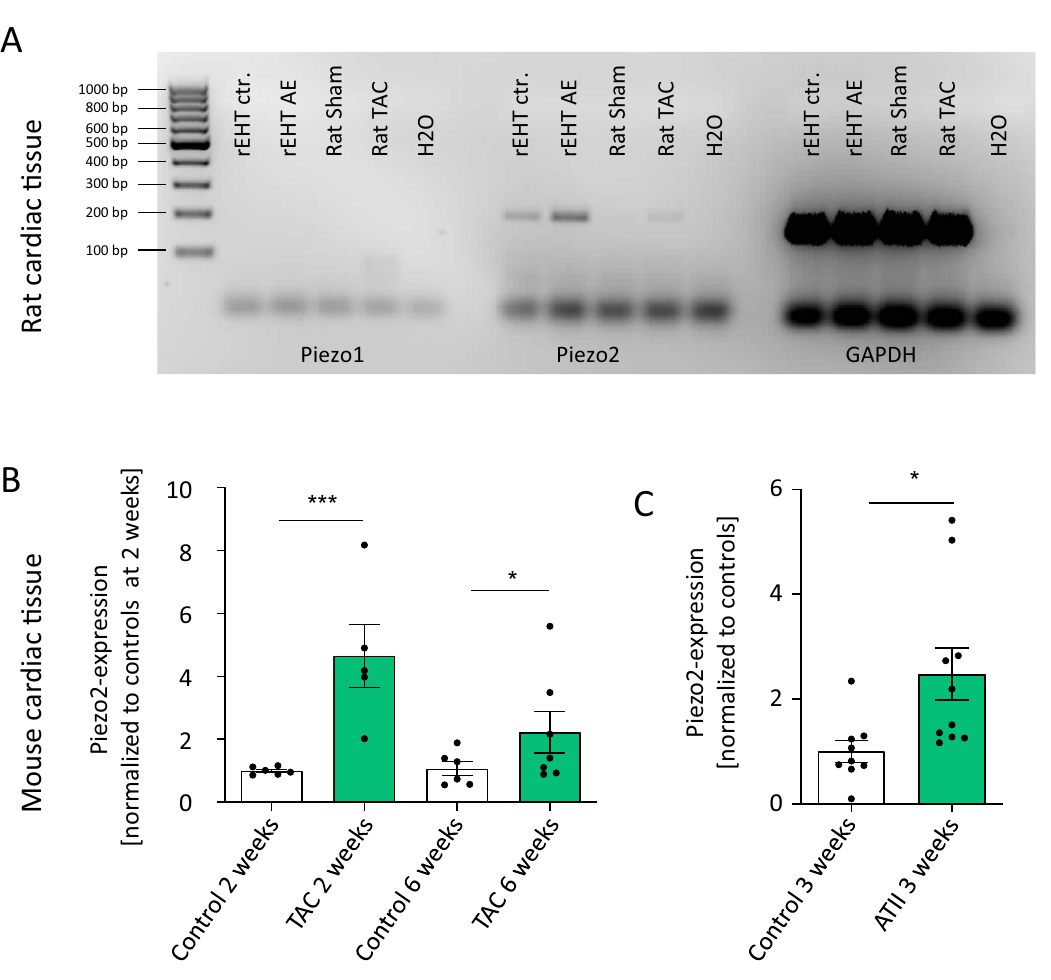
Figure 1. Upregulation of piezo2 in different cardiac stress models. ( A ) Semiquantitative PCRs for piezo1, piezo2 and GAPDH of control and afterload-enhanced (AE) rat EHTs as well as rat left ventricles after sham operation or TAC (transverse aortic constriction) surgery. Each lane represents the PCR-product from one sample (rat or EHT). The expected or detected PCR product sizes were 167 bp (piezo1), 200 bp (piezo2) and 155 bp (GAPDH). ( B ) Quantitative PCR for piezo2 expression in the left ventricles of control mice or after 2 or 6 weeks of TAC (n = 5–7). ( C ) Quantitative PCR for piezo2 expression in the left ventricles of control mice or after 3 weeks of continuous angiotensin II (ATII) application (n = 9–10). In ( B , C ) each dot represents the cardiac piezo2-expression of one mouse, averaged from two technical replicates. For better visualization the mean of control 2 weeks ( B ) or control 3 weeks ( C ) was set to